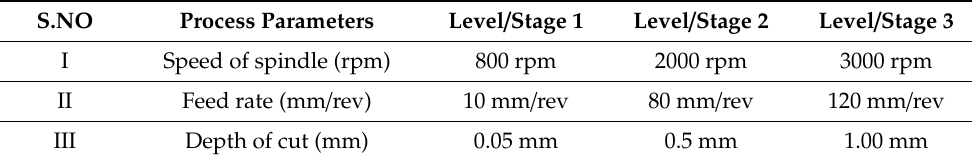
Table 2. Chosen process parameters and their respective